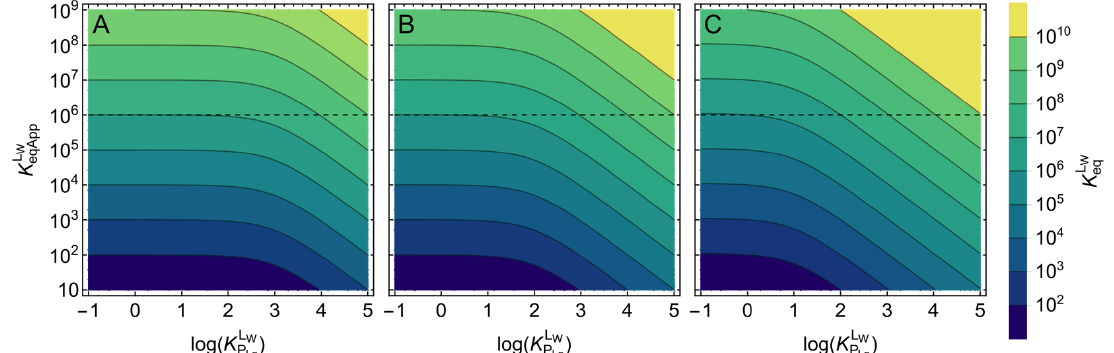
Figure 7. Effect of ligand lipophilicity ( K L W ) on the apparent affinity ( K L W ) for different values eqApp PLb of the intrinsic affinity ( K L W eq ) of binding to a protein in the presence of a lipid bilayer. The colored slabs correspond to a given value of K L W eq (see scale on the right), the value that would be obtained for K L W is the intercept of a horizontal line with the y -axis (exemplified by the dashed line at eqApp = 10 6 ). The volume occupied by the protein was considered negligible, and the volume of the lipid phase was 0.1% (plot ( A )), 1% (plot ( B )), and 10% (plot ( C )). The colored slabs in Figure 7 correspond to a given range of K L W eq , and the value that would be obtained for K L W is obtained from the interception of horizontal lines with the y- axis. The dashed line marks an apparent affinity of 10 6 M − 1 . This same apparent affinity may correspond to intrinsic affinities as high as 10 10 M − 1 , for the highest ligand lipophilicity and volume of the lipid bilayer considered (plot C). This figure may be used to estimate the intrinsic binding affinity from values of apparent affinity reported in the literature. For an accurate use of Figure 7, it is necessary to know the volume of the lipid